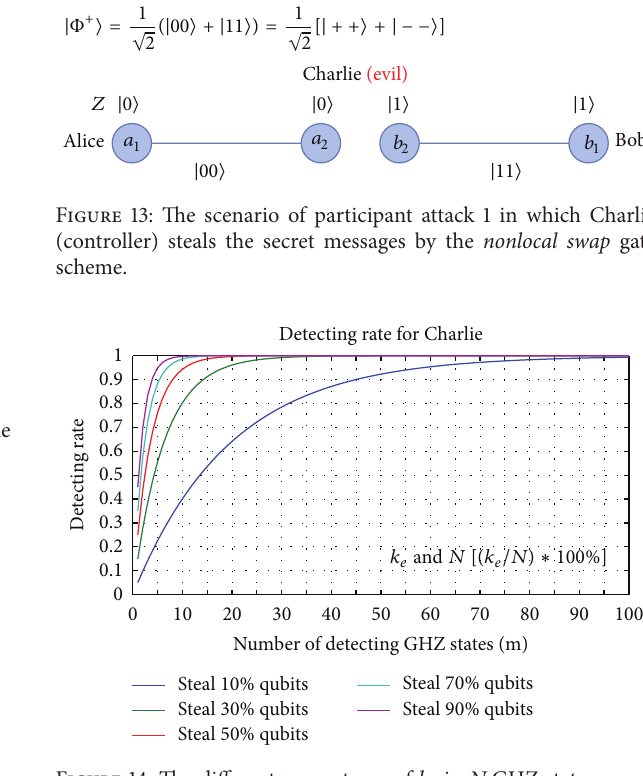
Figure 14: The different percentages of 𝑘 𝑐 in 𝑁 GHZ states corre- sponding to the error detection rate and the number of detecting GHZ states. ( 𝑘 𝑐 : the number of GHZ states replaced by Charlie’s EPR pairs. 𝑁 : the number of GHZ states which are prepared from